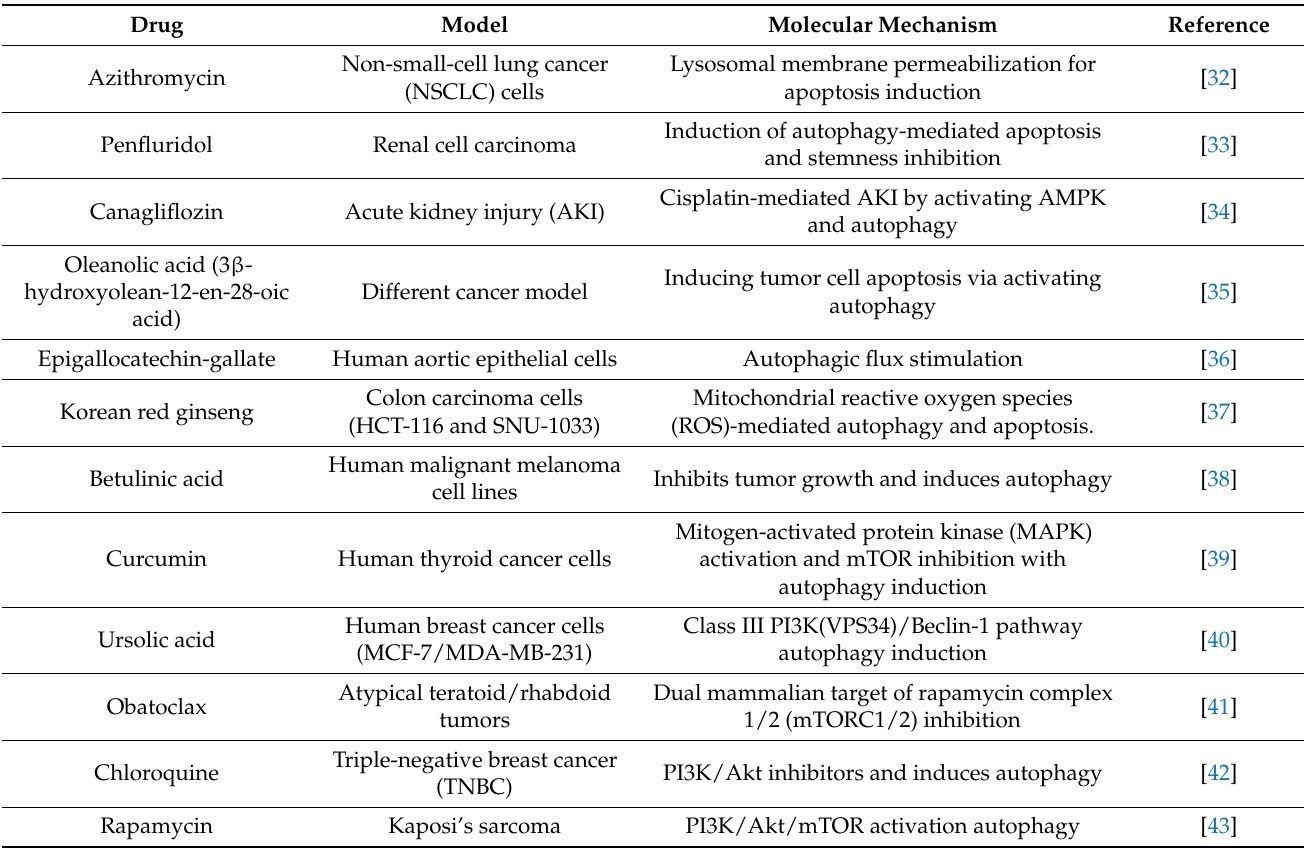
Table 1. Recently used drugs for autophagy stimulation and their mechanisms of